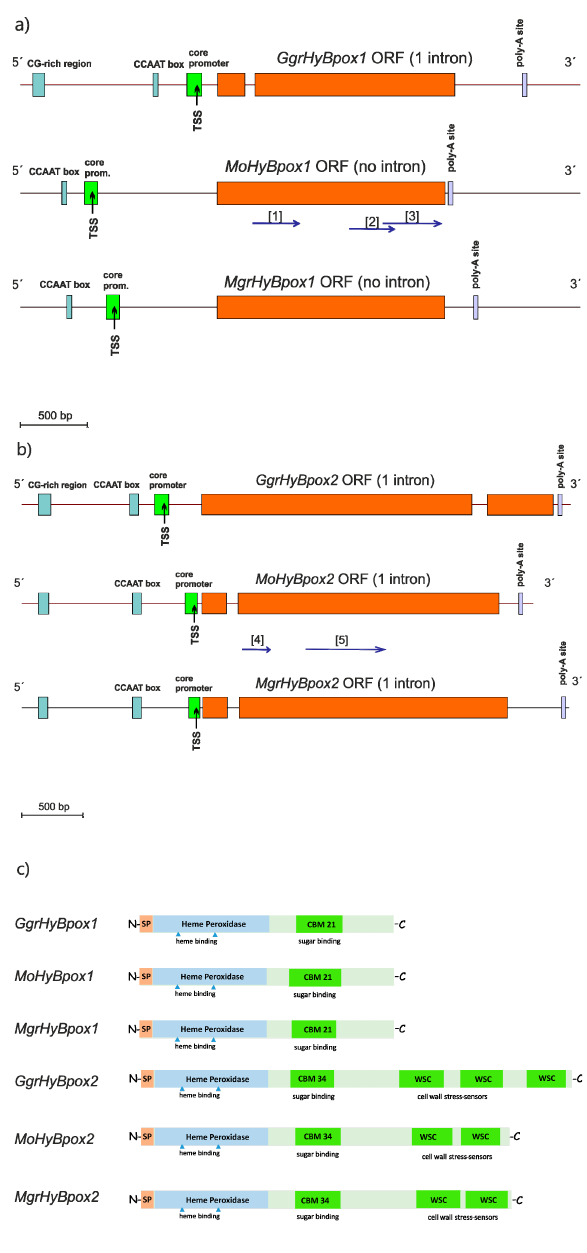
Figure2. GenomicregionscodingforcloselyrelatedHybridBhemeperoxidasesfromphytopathogensof Figure 2. Genomic regions coding for closely related Hybrid B heme peroxidases from the Magnaporthaceae family. Schematically presented are corresponding paralog genomic sequences for phytopathogens of the Magnaporthaceae family. Schematically presented are corresponding paralog ( a ) GgrhyBpox1 from Gauemannomyces graminis (strain R3-111a-1) , for MohyBpox1 from Magnaporthe oryzae genomic sequences for ( A ) GgrhyBpox1 from Gauemannomyces graminis (strain R3-111a-1) , for (strain 70-15) and for MgrhyBpox1 from Magnaporthe grisea (strain DS0505); ( b ) for GgrhyBpox2 , MohyBpox1 from Magnaporthe oryzae (strain 70-15) and for MgrhyBpox1 from Magnaporthe grisea MohyBpox2 and MgrHyBpox2 , respectively. Experimentally obtained mRNA fragments coding for (strain DS0505); ( B ) for GgrhyBpox2 , MohyBpox2 and MgrHyBpox2 , respectively. Experimentally regions of MohyBpox1 are highlighted with blue arrows. Numbers in brackets correspond to GenBank obtained mRNA fragments coding for regions of MohyBpox1 are highlighted with blue arrows. EST accessions [1] JZ969880, [2] JZ970417 and JZ970418 and JZ970399, [3] JZ969979, [4] JZ97400 and Numbers in brackets correspond to GenBank EST accessions [1] JZ969880, [2] JZ970417 and JZ970418 JZ970401 and JZ970402 and [5] JZ970248 and JZ970250. Prediction of promoter elements, introns and and JZ970399, [3] JZ969979, [4] JZ97400 and JZ970401 and JZ970402 and [5] JZ970248 and JZ970250. poly-A sites was performed with FGENESH 2.6 suite [17]. ( c ) Translation products of corresponding Prediction of promoter elements, introns and poly-A sites was performed with FGENESH 2.6 suite mRNAs with schematic presentation of conserved peroxidase and variable non-peroxidase domain [17]. ( C ) Translation products of corresponding mRNAs with schematic presentation of conserved motifs. Drawn to scale according to peroxidase and variable non-peroxidase domain motifs. Drawn to scale according to predictions.